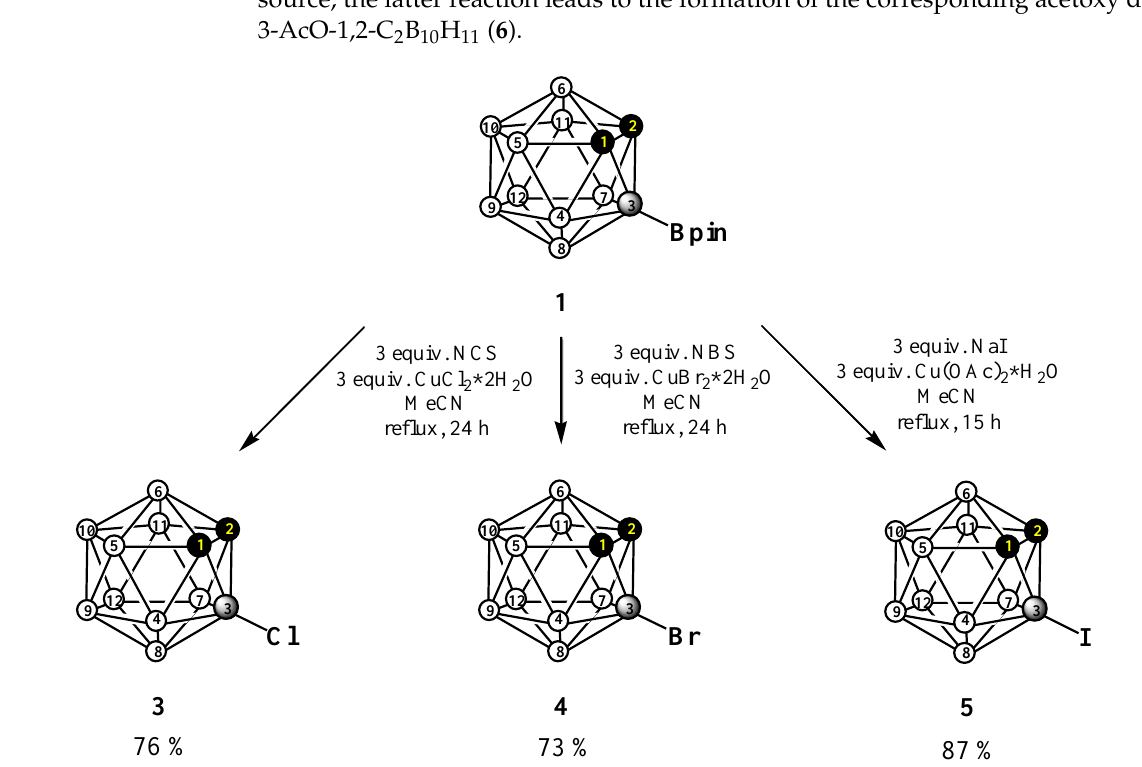
Scheme 2. Synthesis of 3-halogen derivatives 3-X-1,2-C 2 B 10 H 11 (X = Cl ( 3 ), Br ( 4 ), I ( 5 )).